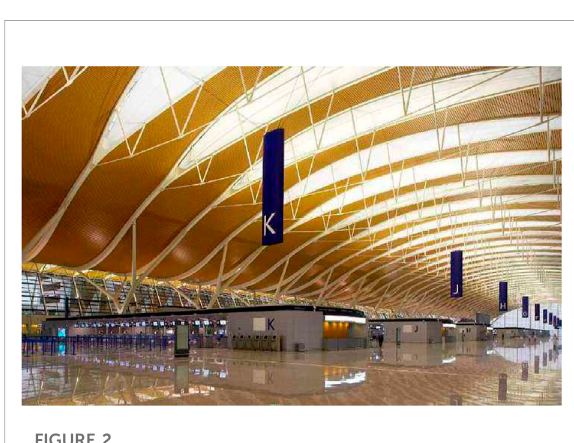
FIGURE 2 T2 terminal for Shanghai Pudong International Airport.